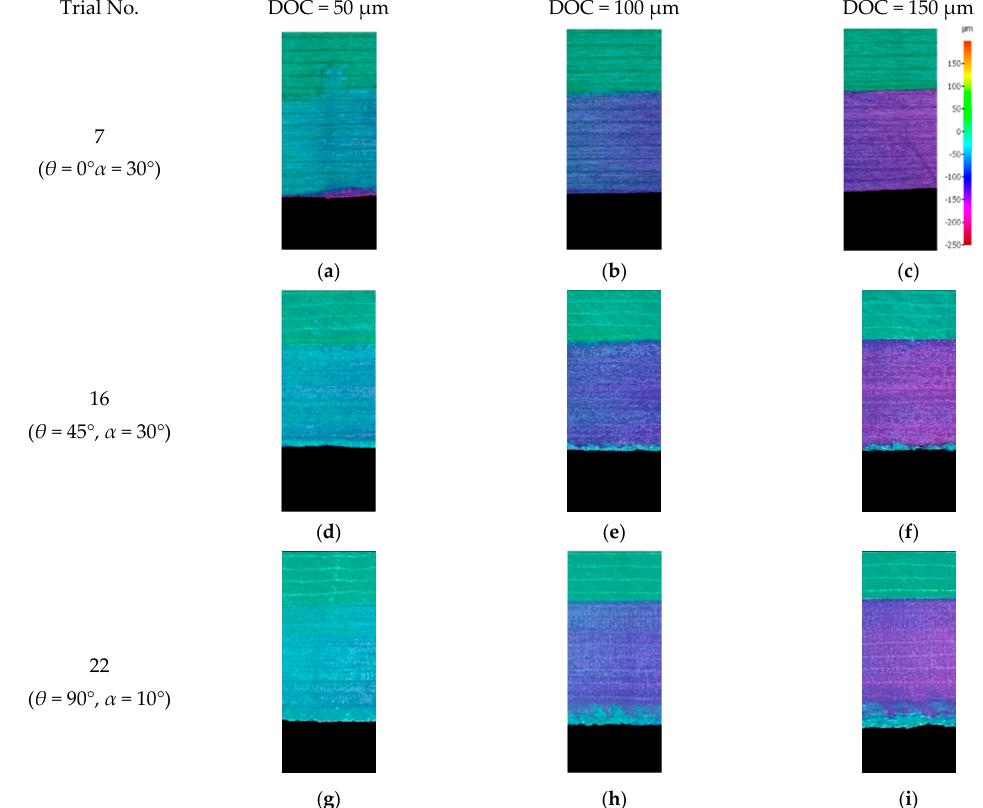
Figure 15. Effect of fibre orientation and tool rake angle on the depth of cut of 100 µm and 𝑉 (cid:3030) (cid:3404) 570 mm/min. Trial No.